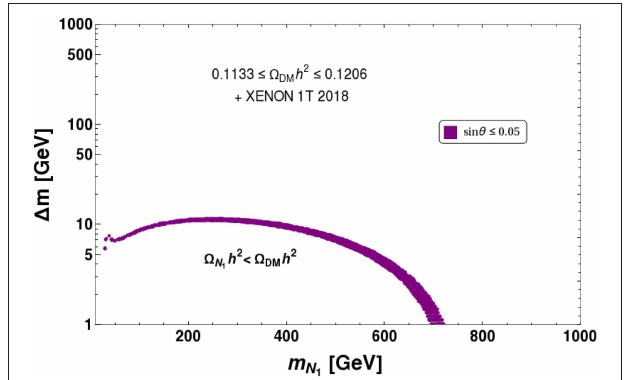
FIGURE 25 | Relic density and direct detection (XENON 1T 2018) allowed parameter space plotted in m N